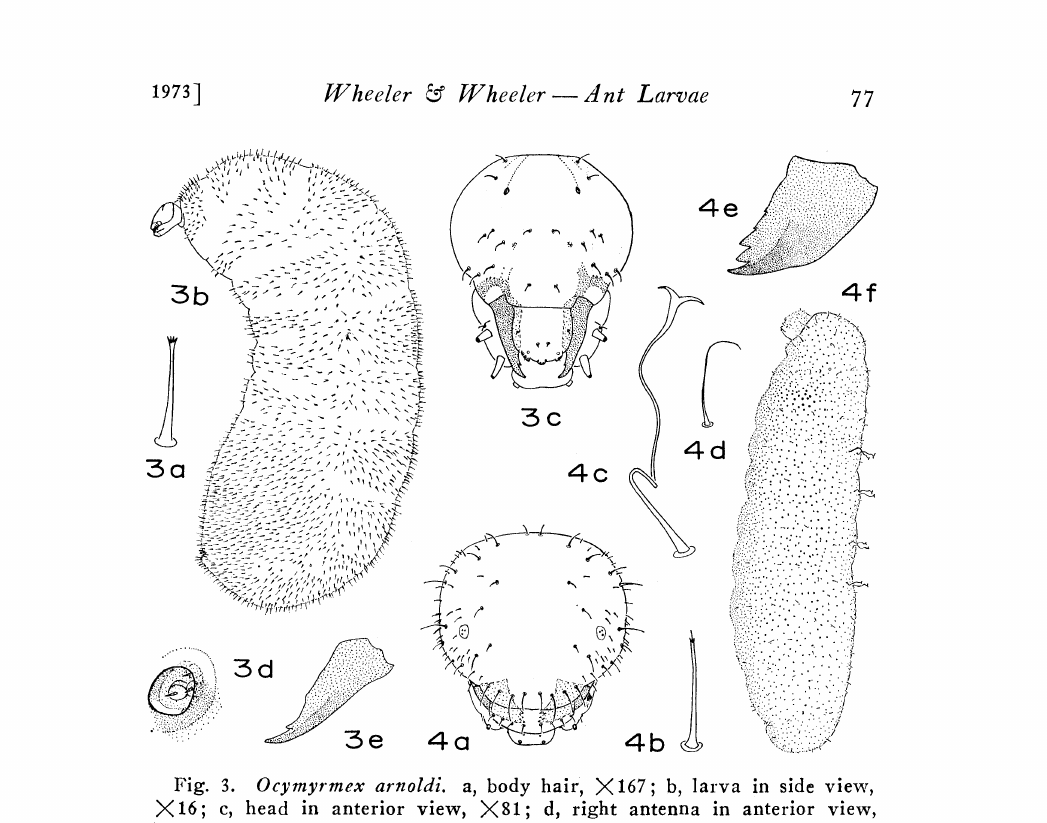
Fig. 3. Ocymyrmex arnoldi, a, body hair, X167; b, larva in side view, X16; e, head in anterior view, 81; d, right antenna in anterior view, X376; e, left mandible in anterior view, X133. Fig?. 4. Proc’rytocerus adlerzi, a, head in anterior view, X67; b-d, three types of body hairs, X267; e, left mandible in anterior view, X185; f, larva in side view,